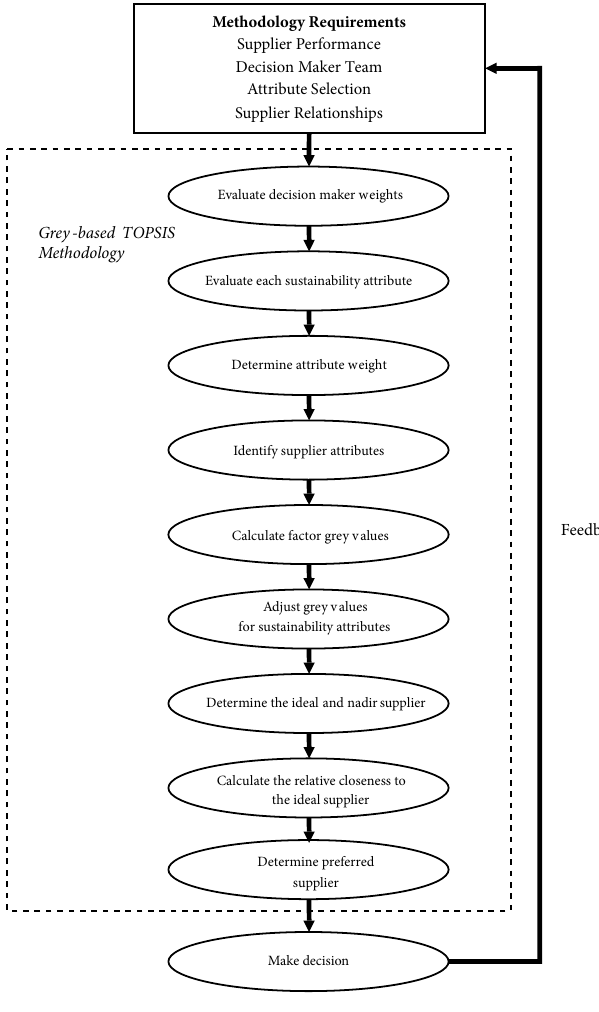
Figure 1. Various steps and environment of the joint Grey number and TOPSIS